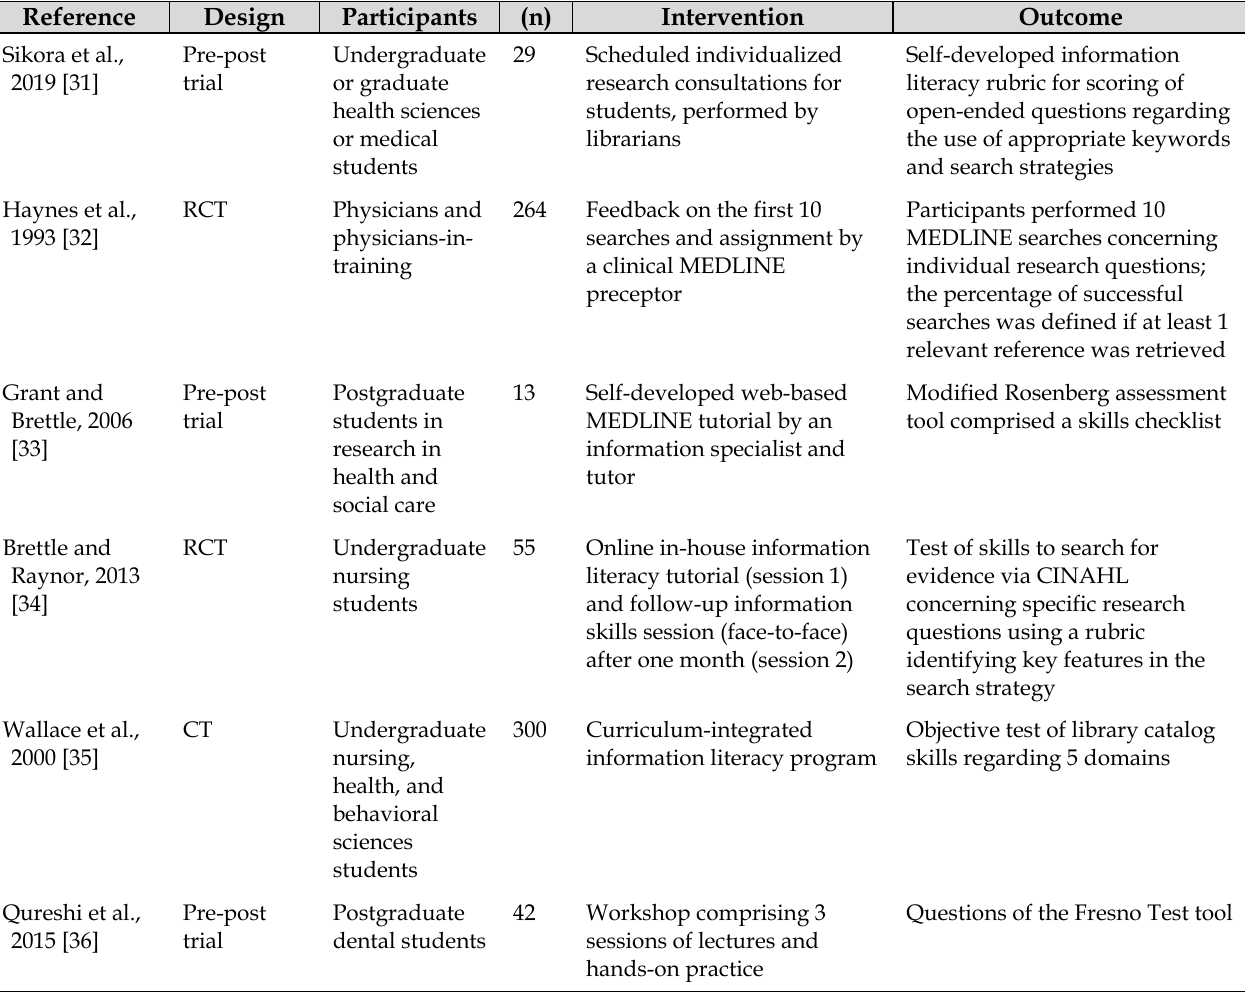
Table 1 Characteristics, interventions, and outcomes of included studies (continued)